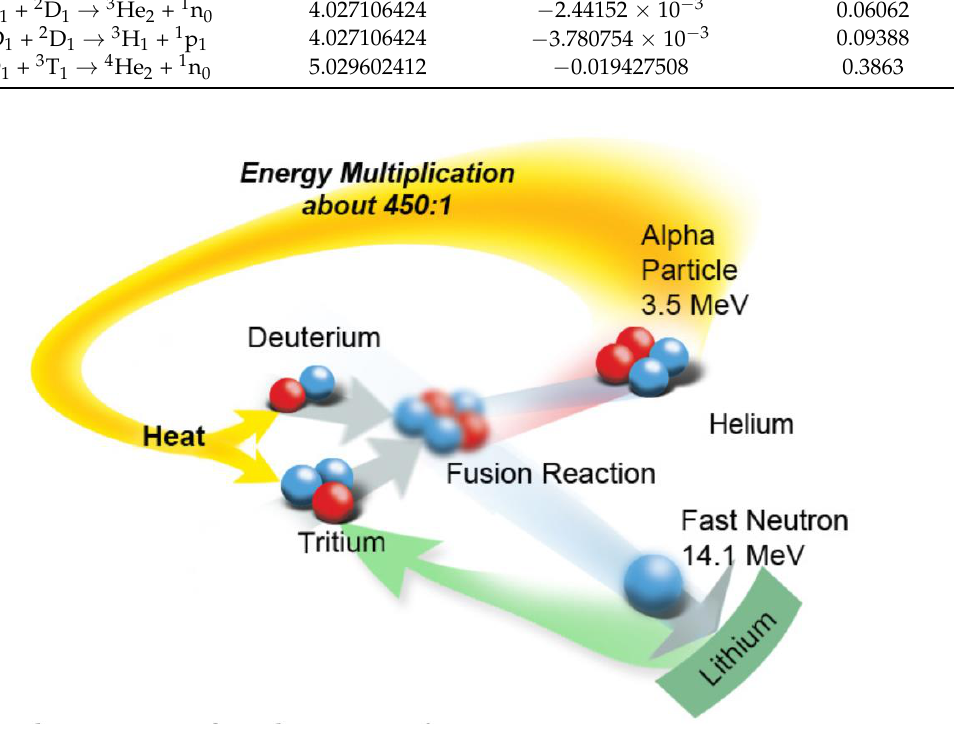
Figure 2. Schematic of the D – T fusion reaction. © 2018 US ITER.